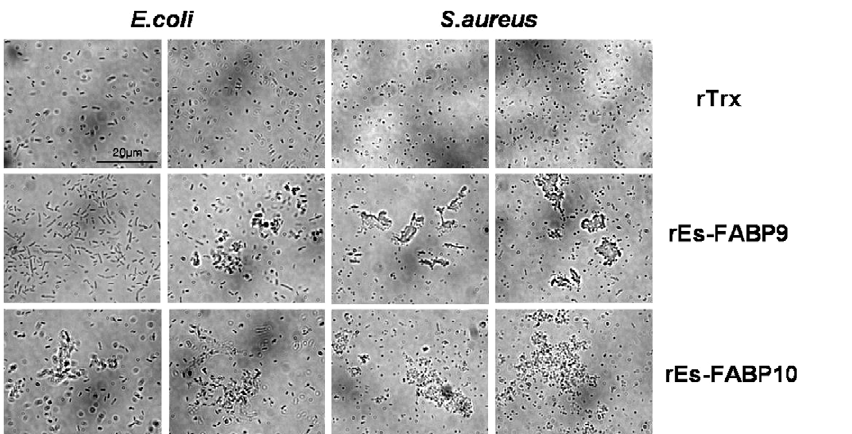
Figure 6. rEs-FABPs possessed antimicrobial activity. Growth suppression tests of TBS and rEs-FABPs against Gram-negative and Gram-positive bacteria. OD 600 values were measured every 2 h after starting the cultures, and the growth curves were drawn. (a, b): S. aureus (G + ) and V. parahaemolyticus (G 2 ) mixed with rEs-FABP9 respectively, (c, d): A. hydrophila (G 2 ) and B. subtilis (G + ) mixed with rEs-FABP10 respectively. The data are the average 6 SD of three independent cultures. ---, 0 m g; ---, 10 m g; ---, 20 m g; ---, 30 m g.